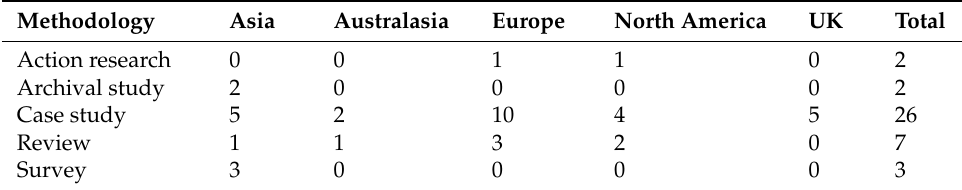
Table 4. Methodologies adopted by the selected papers classified by country areas.